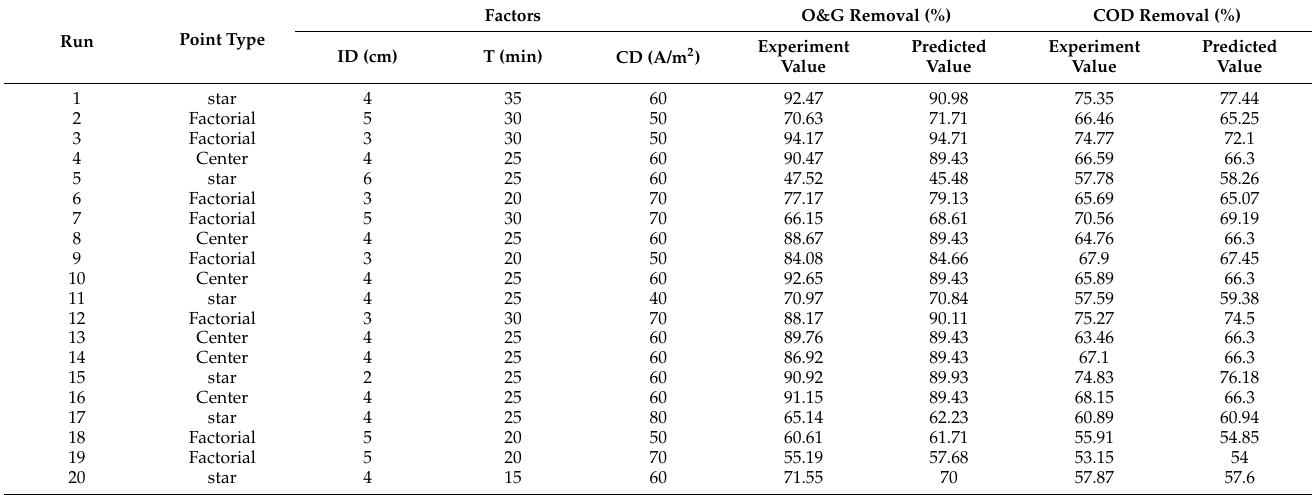
Table 4. Design matrix CCD showing actual and predicted